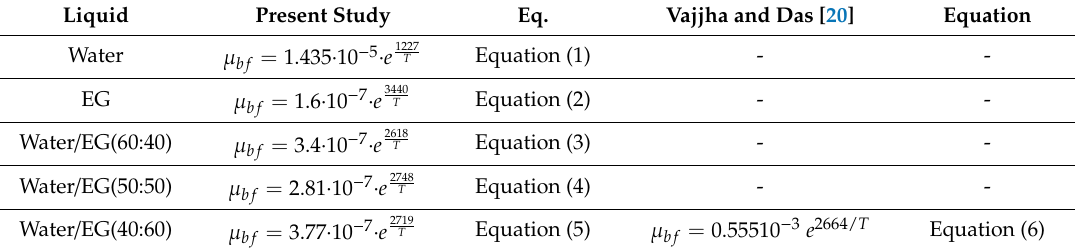
Table 1. Correlations for the dynamic viscosity of the base